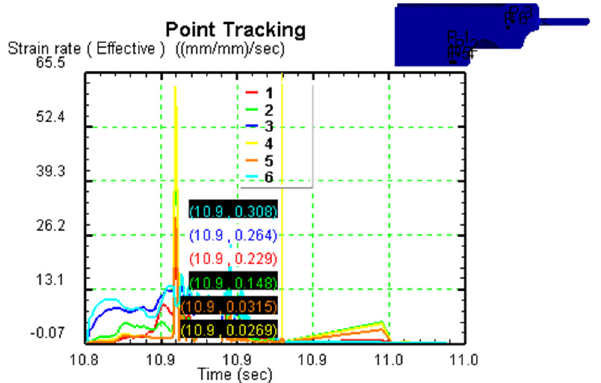
Figure 17. Strain-rate nephogram at the end of the molding process (deformation temperature is 1090 °C).